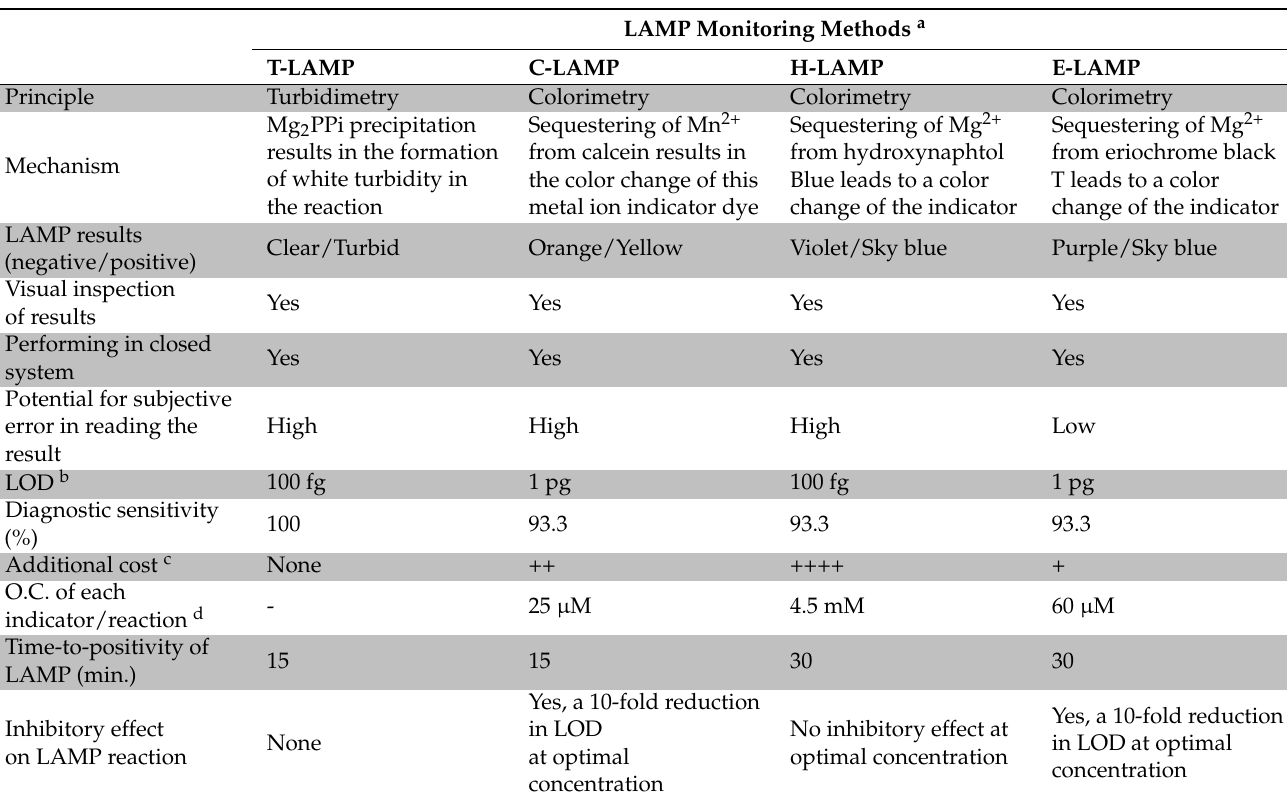
Table 3. A brief comparison among the four monitoring methods of LAMP used in this study for Mtb